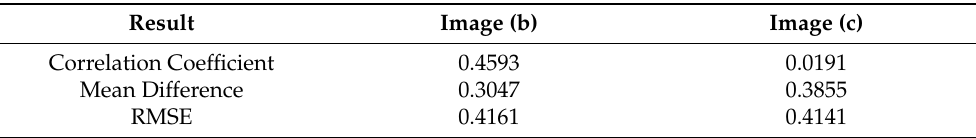
Table 5. Measured currents processed with the ECWMF wind field, and a comparison with GF − 3 and HFSWR.